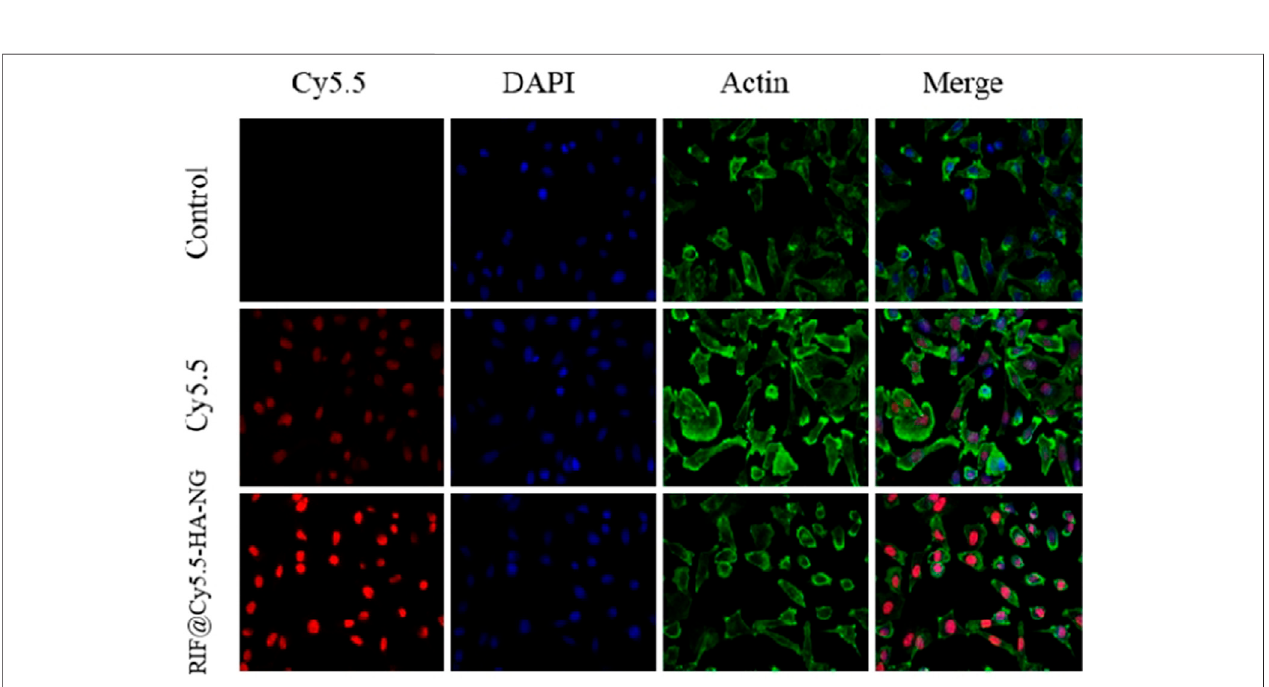
FIGURE2| UptakeofRIF@Cy5.5-HA-NG.Blue fl uorescentimageindicatestheimageofDAPIstainedcells.Red fl uorescenceindicatesuptakeofCy5.5andRIF@ Cy5.5-HA-NG. Green fl uorescent image indicates the image of Actin. To demonstrate the uptake of RIF@Cy5.5-HA-NG nanoparticles, the laser confocal experiment was performed and the section-wise imaging of intracellular localization of nanoparticles was shown.